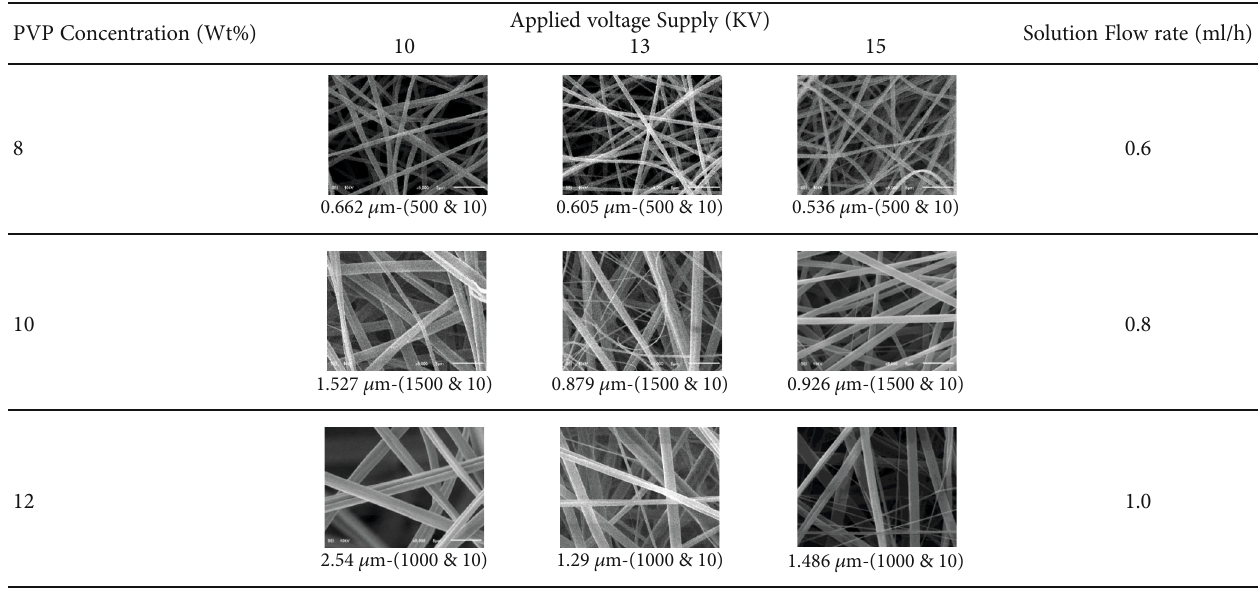
Table 5: SEM images to study fi ber morphology at di ff erent levels of polymer concentration, voltage applied, fl ow rate, RPM, and collection